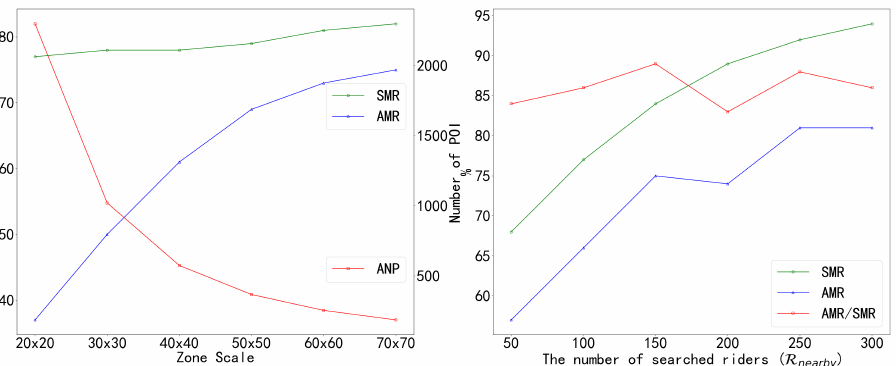
Figure 7. SMR, AMR, and ANP under different zone scales when the number of searched riders is 100 ( left ) and SMR, AMR, and AMR/SMR under different sizes of R nearby when the zone scale is 50 × 50 ( right